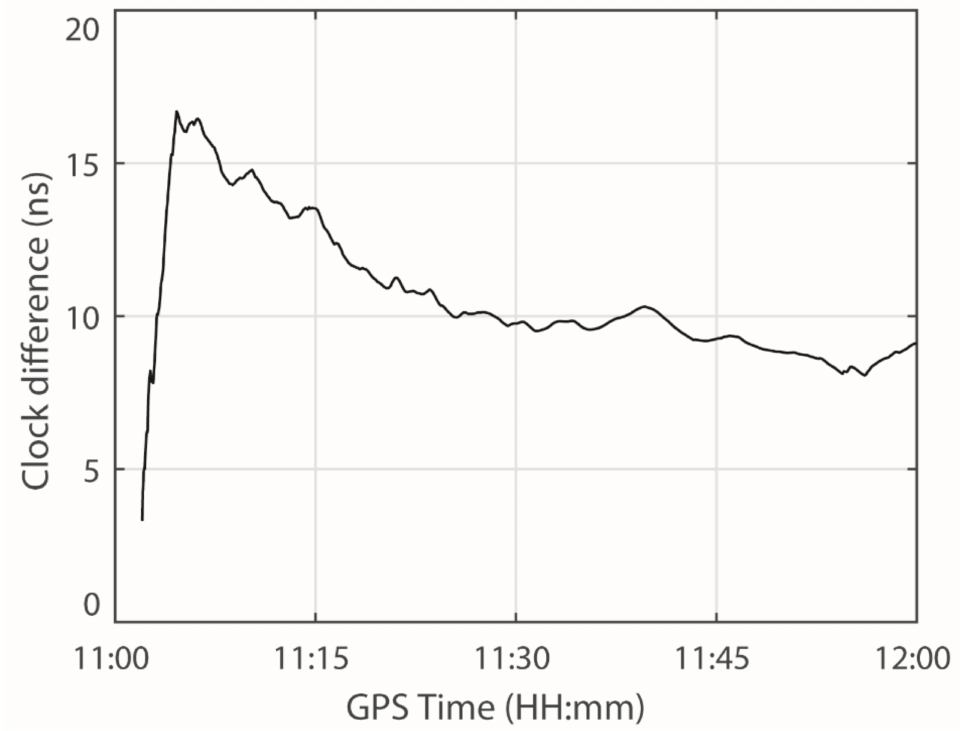
Figure 9. Receiver clock offset difference between standard PPP and position- and ZWD-constrained PPP with inherited